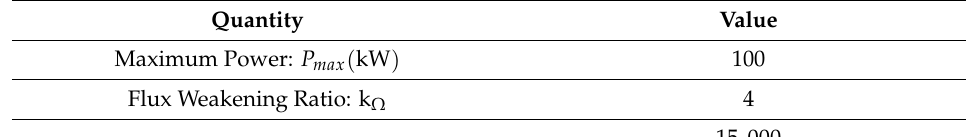
Table 3. Electric vehicle specifications of electric machine